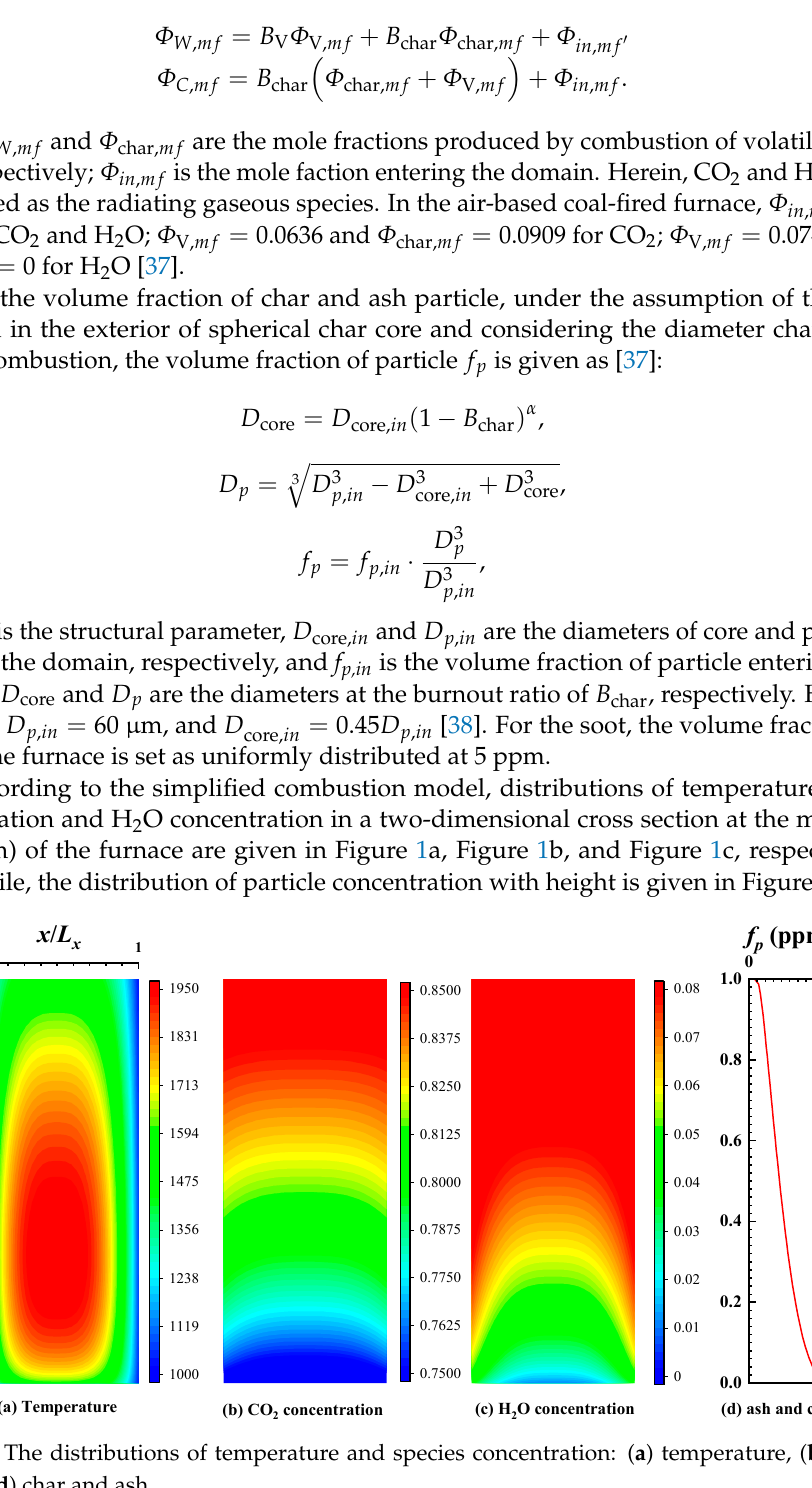
Figure 1. The distributions of temperature and species concentration: ( a ) temperature, ( b ) CO 2 , ( c ) ( c ) H 2 O, ( d ) char and H 2 O, ( d ) char and ash.